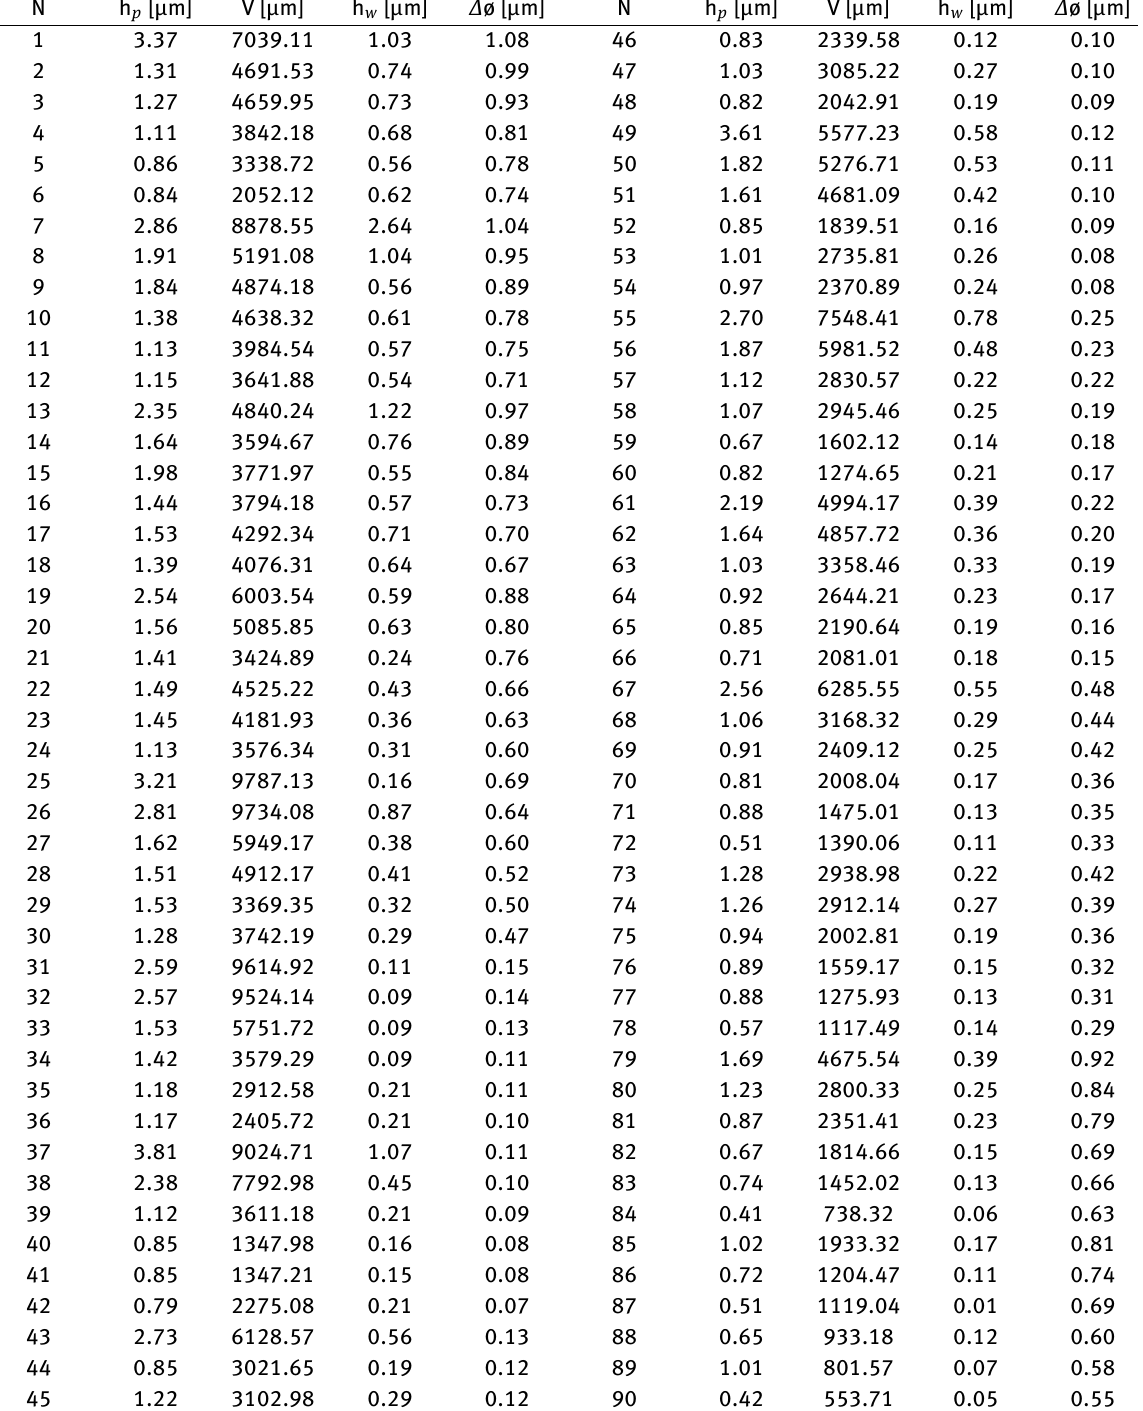
Table 2: Results of measurements of geometry of tested